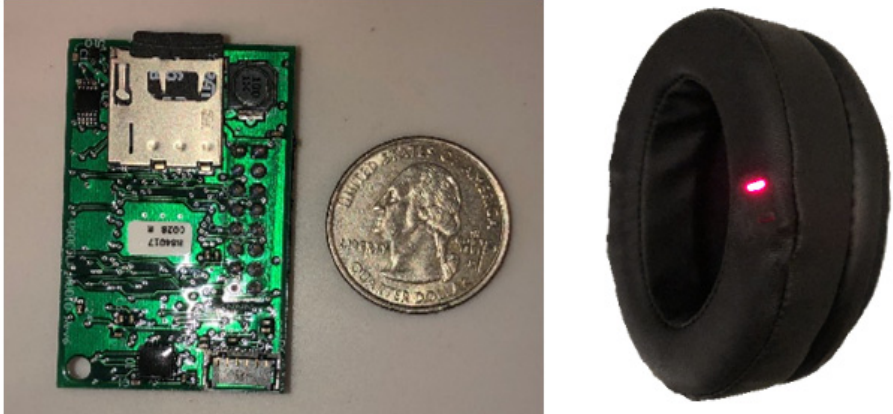
Figure 1. The SPYDR earcup system is a self-contained unit that can act as a functional replacement for earcup in standard flight helmets or headsets. Photograph of SPYDR’s internal processor and circuit board ( left ) and assembled SPYDR earcup ( right ) with PPG sensor embedded within the earseal at the red light.